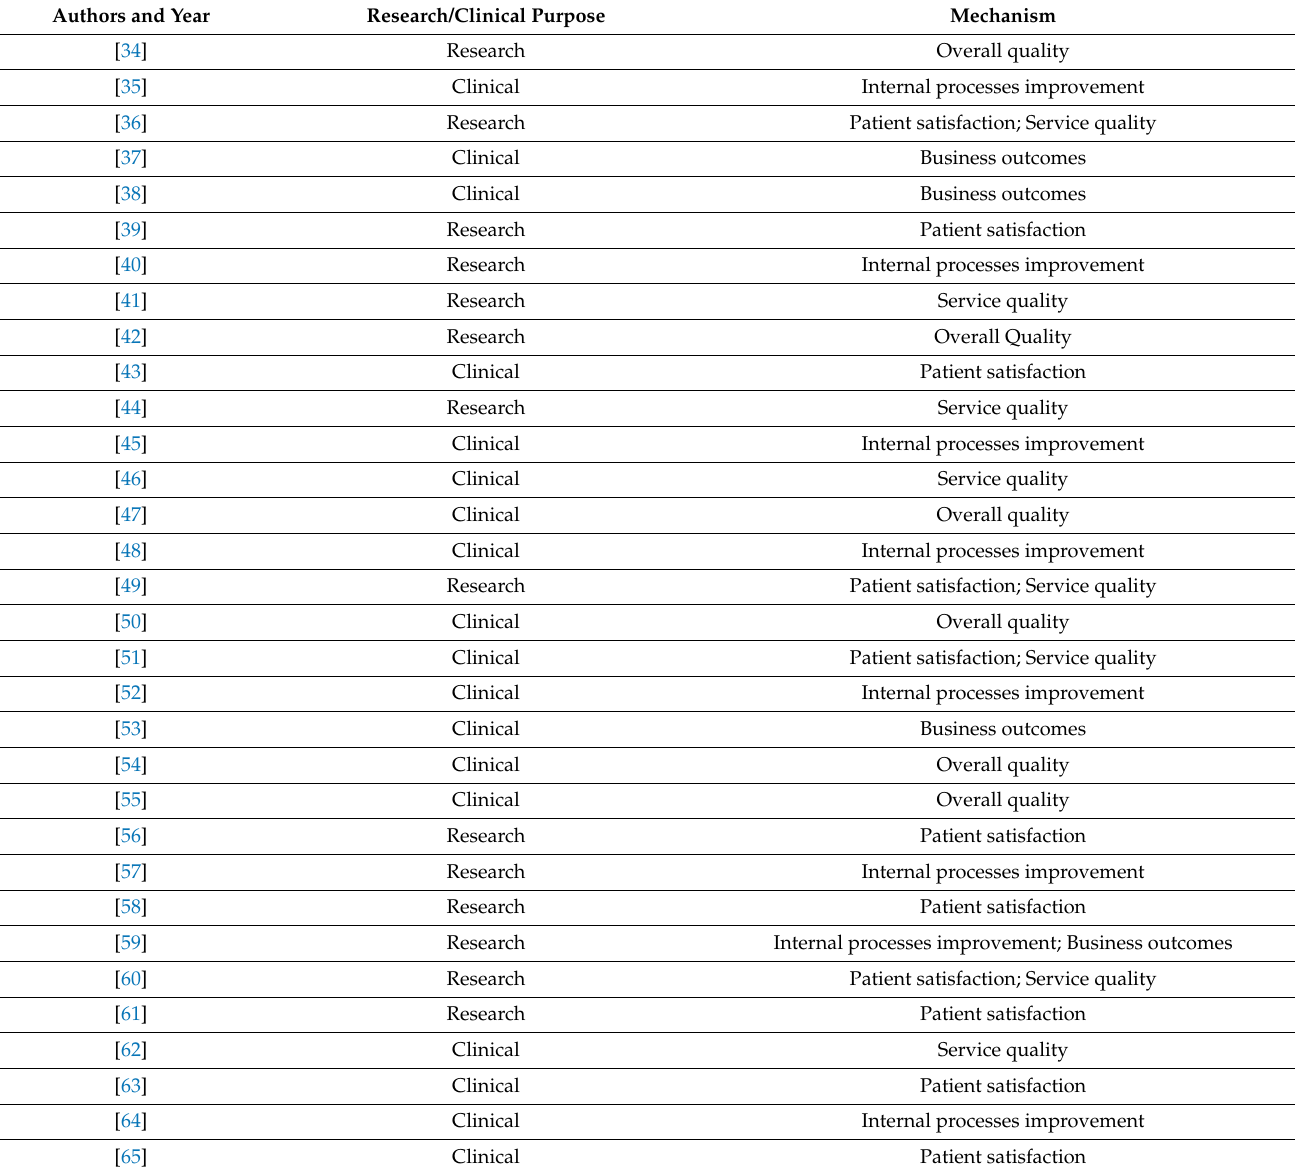
Table 1. Sources included in the review and main CIMO